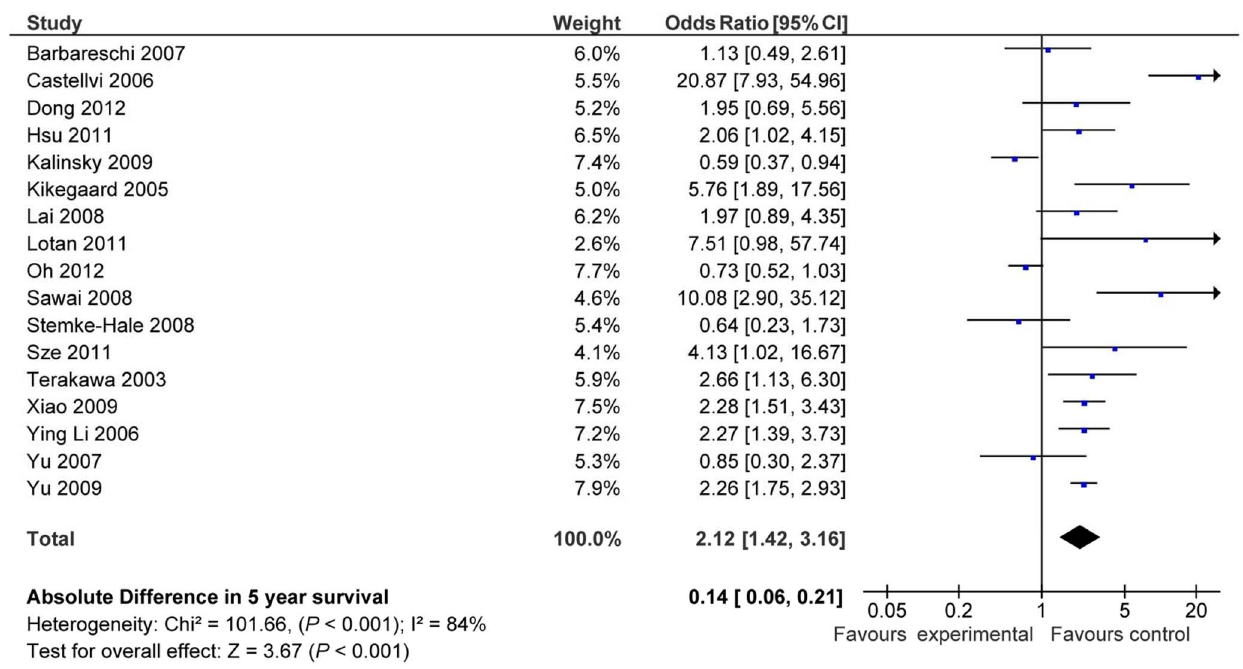
Figure 2. Odds ratio (OR) for 5-year overall survival (OS) in all studies. Forest plots of odds ratios for overall survival at 5 years based on activation of the PI3K/mTOR/AKT pathway. Odds ratios for each trial are represented by the squares, the size of the square represents the weight of the trial in the meta-analysis, and the horizontal line crossing the square represents the 95% confidence interval. The diamonds represent the estimated pooled effect based for each cohort individually (labeled subtotal) and for all cohorts together (labeled total).